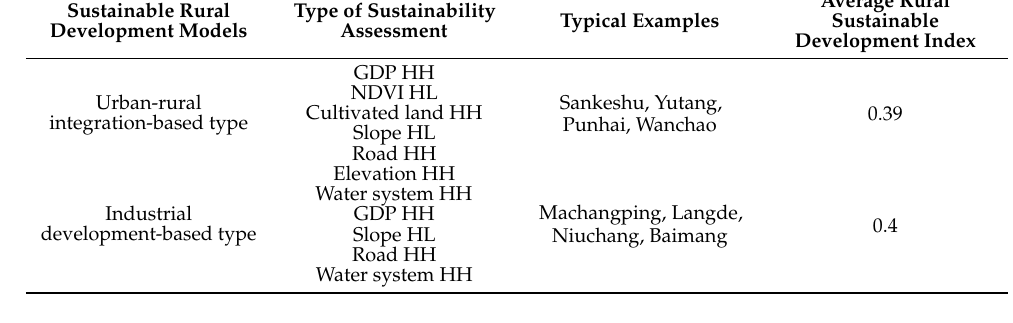
Table 5. Classification of rural development types based on local autocorrelation.